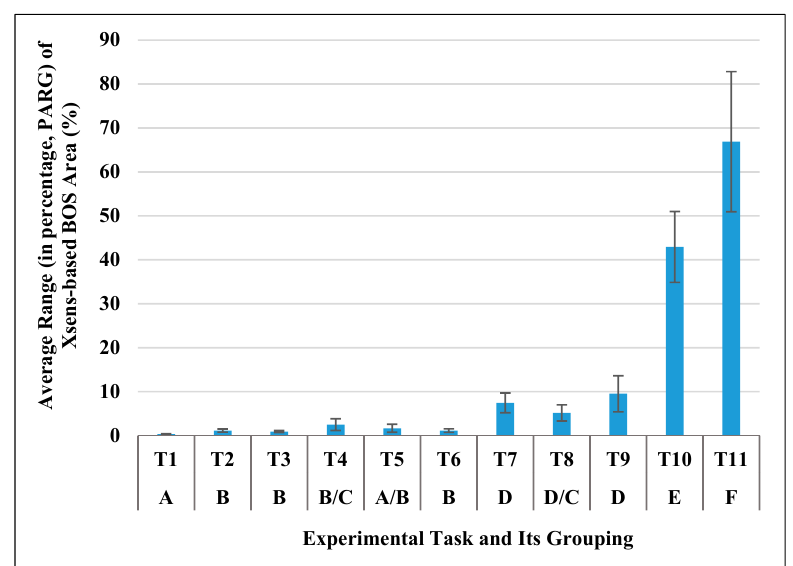
Figure 8. Average range (in percentage, PARG) of Xsens-based BOS area during each experimental task and post-hoc grouping result (Same letters indicate no significant difference). Sensors 2017 , 17 , 2091